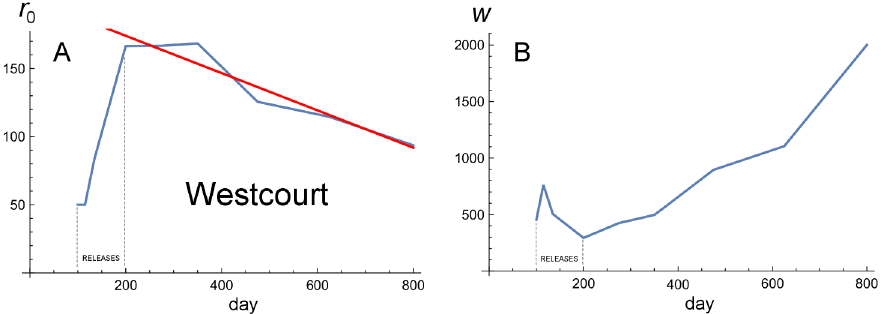
Fig 7. Likelihood analysis of the Westcourt (WC) data. Panels A and B plot the estimates of r 0 and w (from S6 Table) through time for WC. See the text for discussionand interpretation.